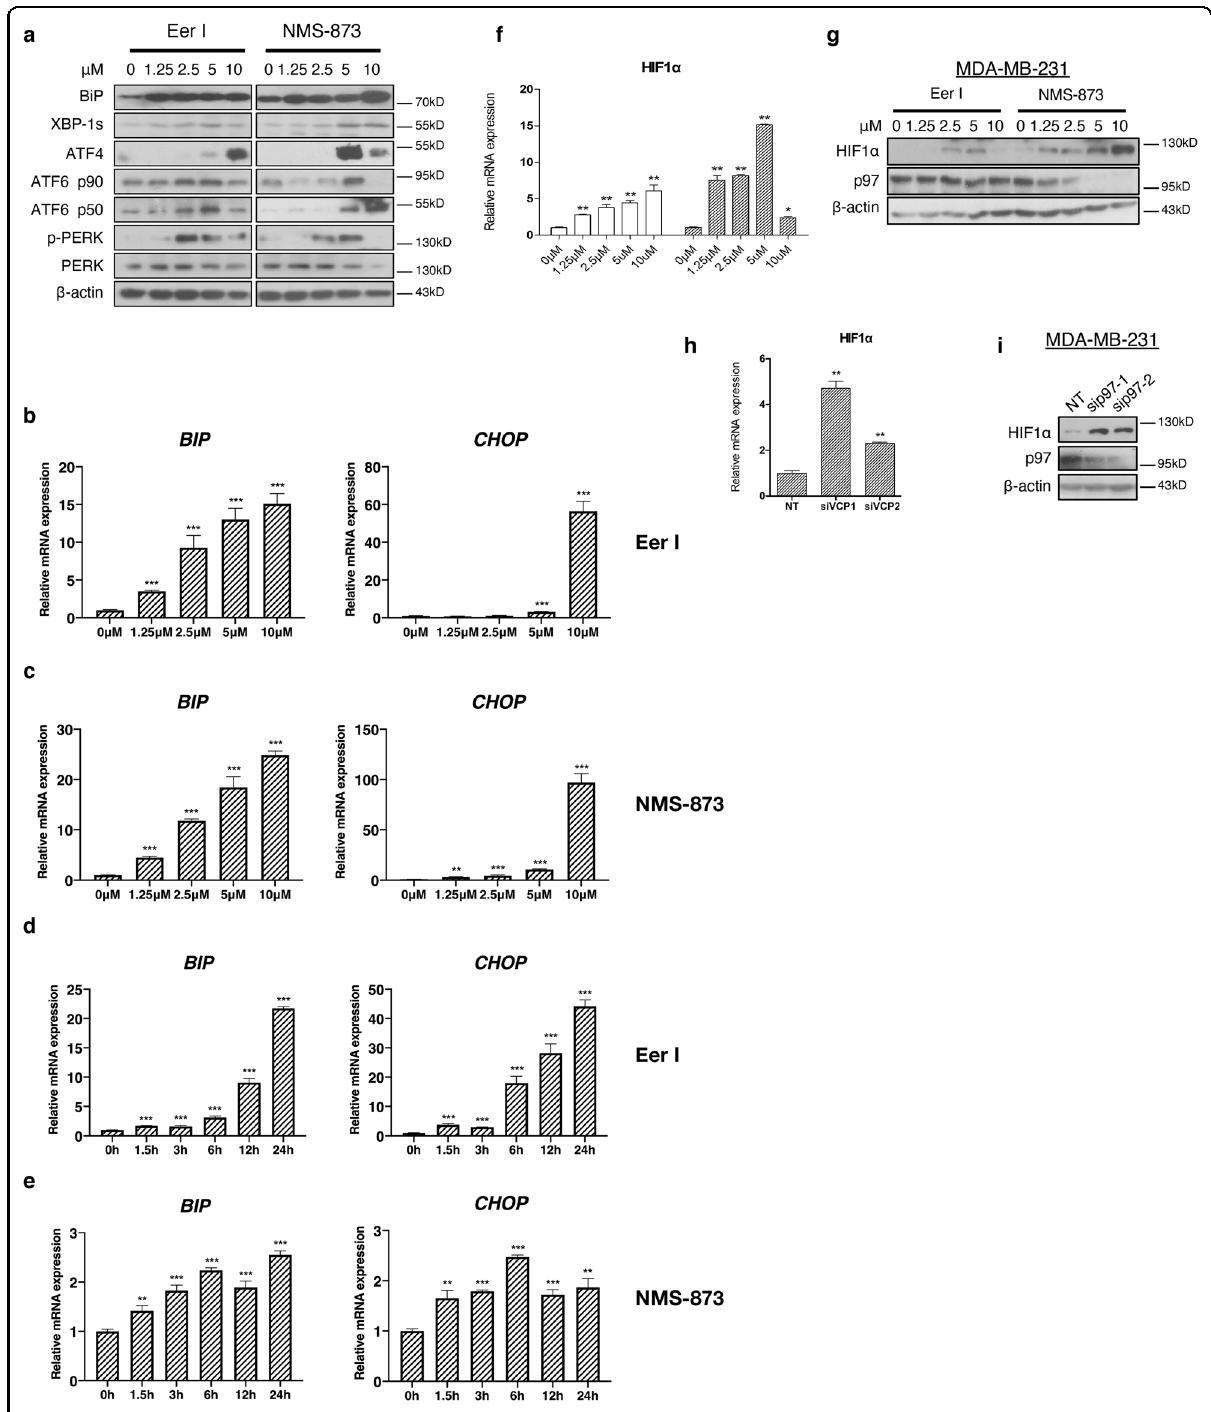
Fig. 5 Loss of p97 activates UPR and increases HIF-1 α expression. a Immunoblotting analysis of BIP, XBP1s, ATF4, ATF6 p90, ATF6 p50, PERK, and pPERK from the MDA-MB-231 cells treated with increasing concentrations of Eer I and NMS-873. β -actin serves as a loading control. b , c qPCR analysis of BIP and CHOP from the MDA-MB-231 cells treated with increasing concentrations of Eer I or NMS-873. d , e qPCR analysis of BIP and CHOP from the MDA-MB-231 cells treated with 2.5 μ M Eer I or NMS-873 from 1.5 to 24 h. f , g qPCR and immunoblotting analysis of HIF-1 α from the MDA-MB-231 cells treated with 2.5 μ M Eer I or NMS-873. h, i qPCR and immunoblotting analysis of HIF-1 α from the MDA-MB-231 cells with p97 depleted. β -actin serves as a loading control. Data were shown as mean + SD. * P < 0.05, ** P < 0.01, and *** P <